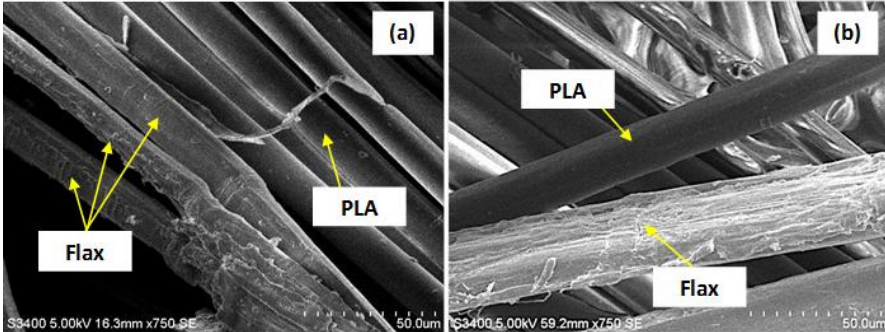
Figure 7. SEM images of surface morphology of ( a ) Flax/PLA, ( b ) Pm-Flax/PLA (150 W)